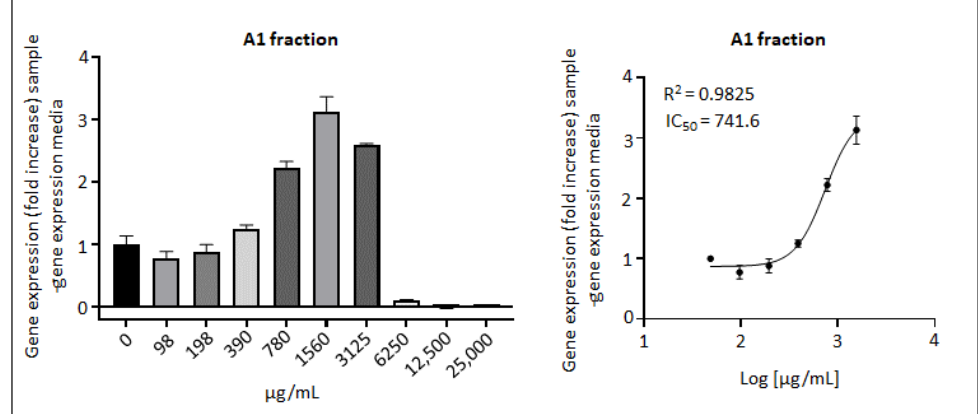
Figure 3. NRF2/ARE-mediated pathway activation by the fraction A1 in stable ARE-driven luciferase expression HepG2 cells. Cells were treated for 17 h with increasing doses of AE and fractions A1, A2, and A3. Only the A1 fraction showed a dose – response effect. On the left side, results are presented in gene expression fold increase compared with the control (cell culture medium only, gene expression = 1). Values under 1 indicate cytotoxicity effect. The bars are SD for mean relative luminescence units of duplicate. On the right side, the same results are presented as a dose – response curve (EC 50 : 742 µg/mL, 95% CI: [582.5, 944.9]). Data points correspond to the fold increase for each concentration and bars are SD. EC 50 is Efficacy Concentration which leads to half-maximal response. R 2 is the coefficient of determination obtained by non-linear regression model fit.